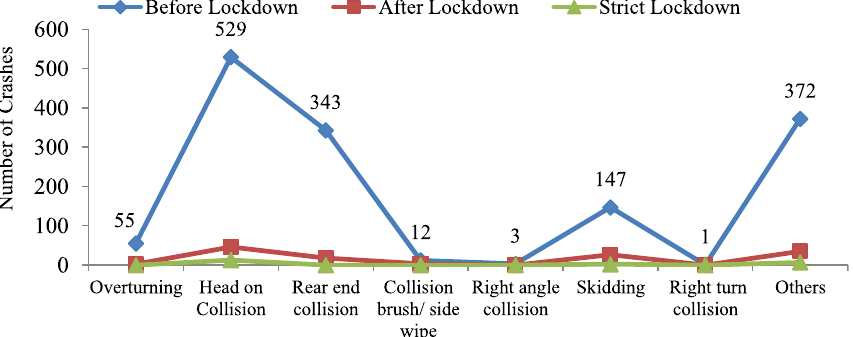
Fig. 2 Analysis of crash data by nature of